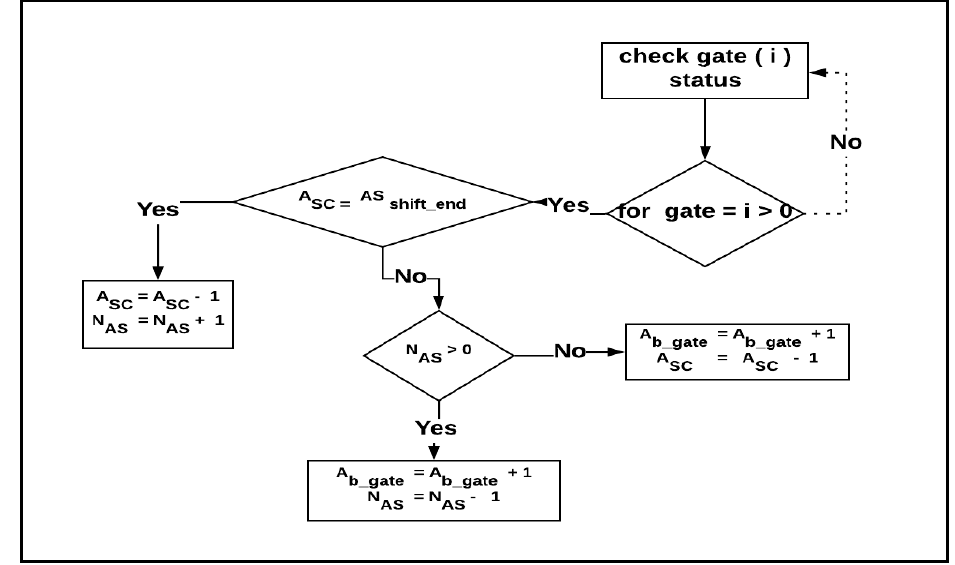
Figure 5. Algorithmic approach for the integrated module for the boarding procedure.